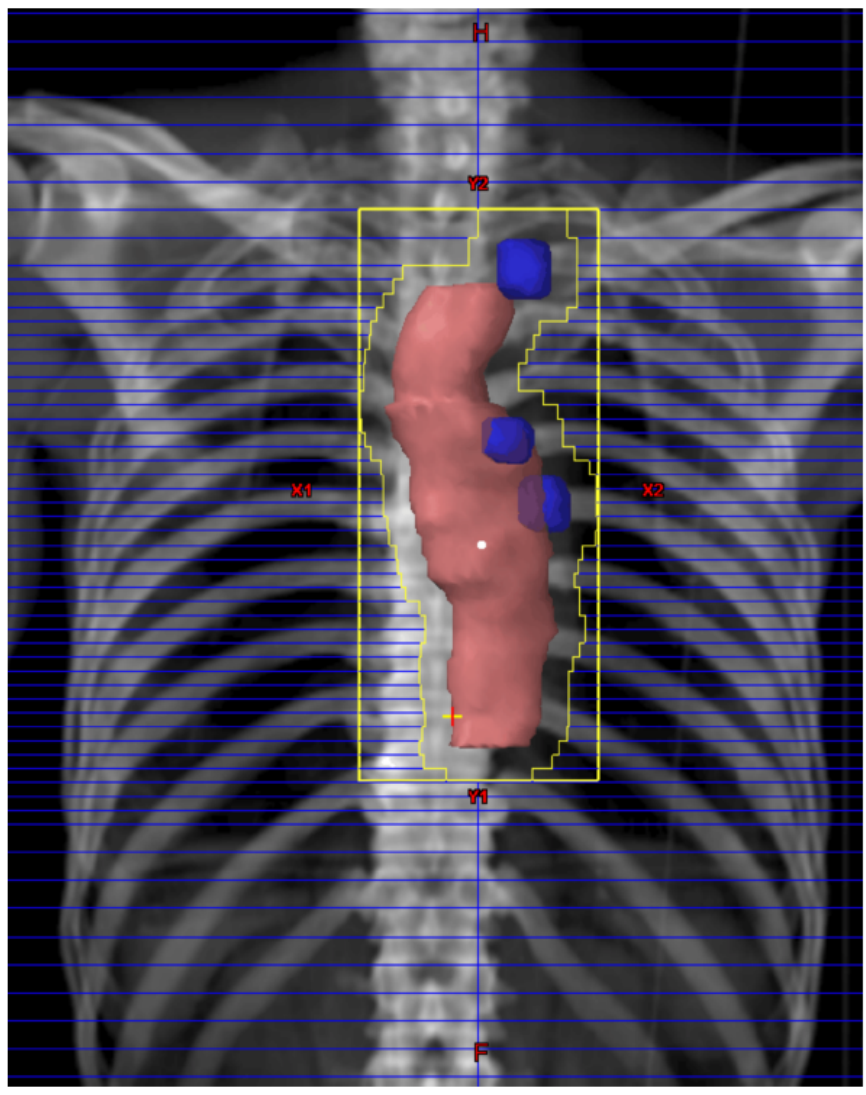
Figure 1. Representative radiation field in a middle thoracic ESCC patient. Shown is a beam’s eye view of the anterior field in a 69-year-old male with advanced middle thoracic ESCC staged as clinical T3N2M0. The pink structure is the primary esophageal lesion with a 3-cm craniocaudal margin. The blue structures are clinically metastatic lymph nodes.